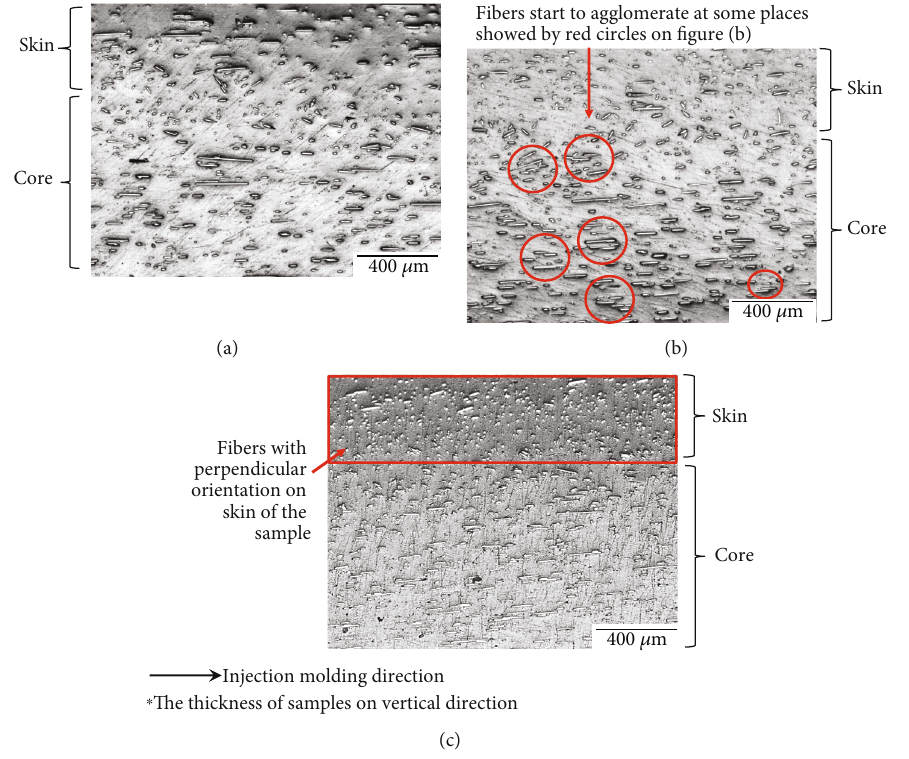
Figure 6: OM images of longitudinal section of (a) 10 wt%, (b) 13wt%, and (c) 15wt% of